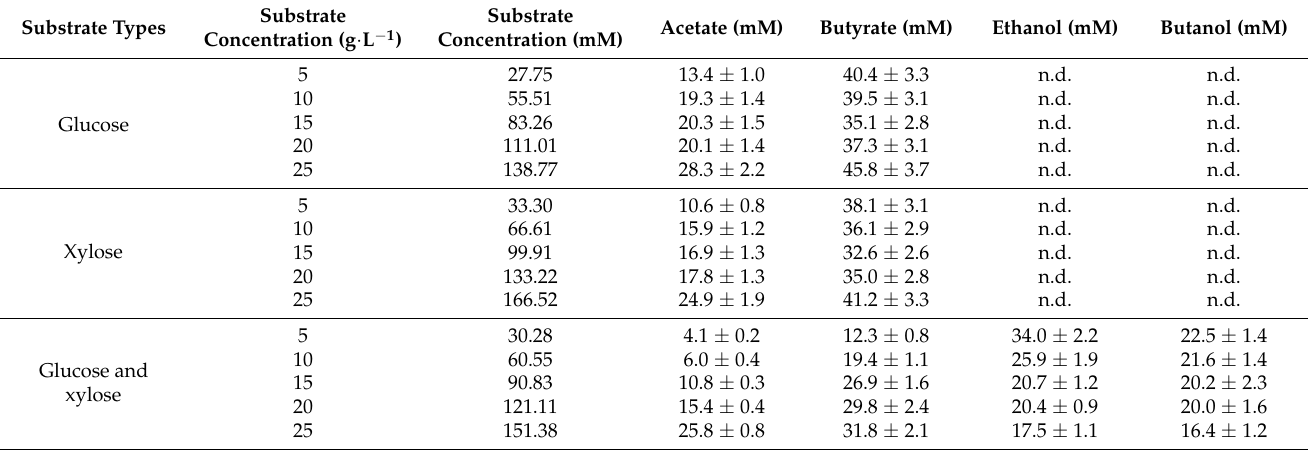
Table 3. Metabolic end products of bio-hydrogen production from glucose, xylose, and glucose and xylose mixture at varying